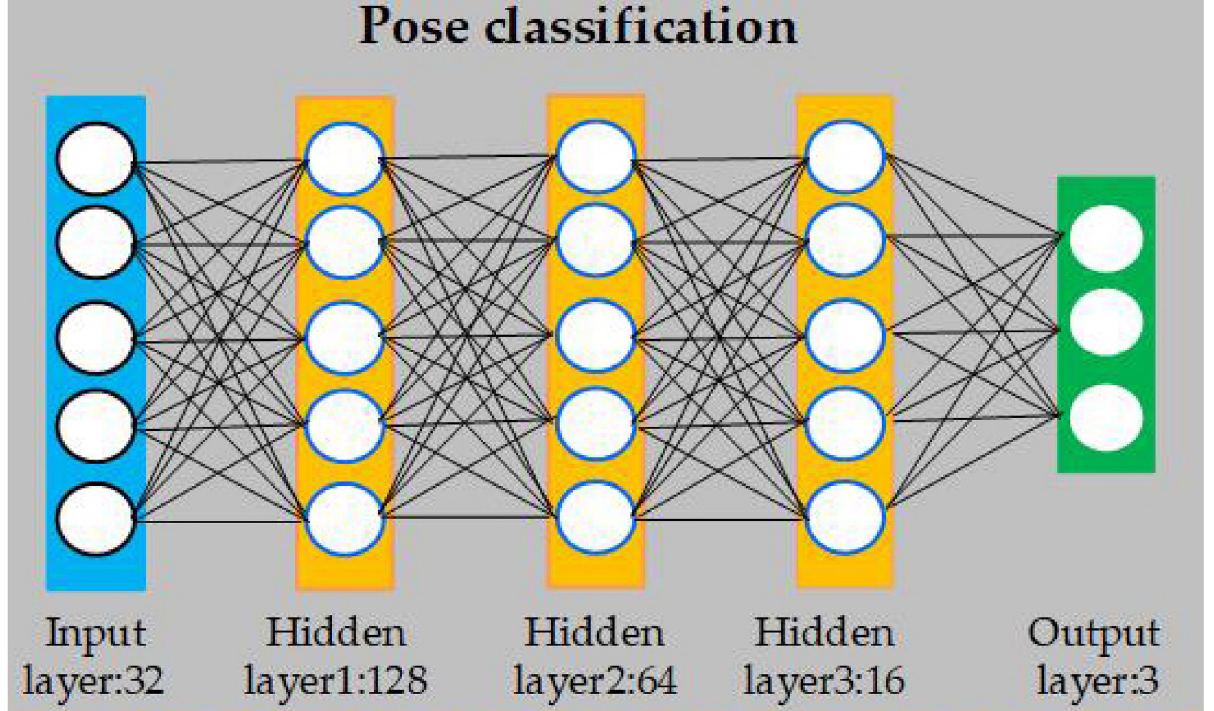
Fig 4. Fully connected neural network of pose